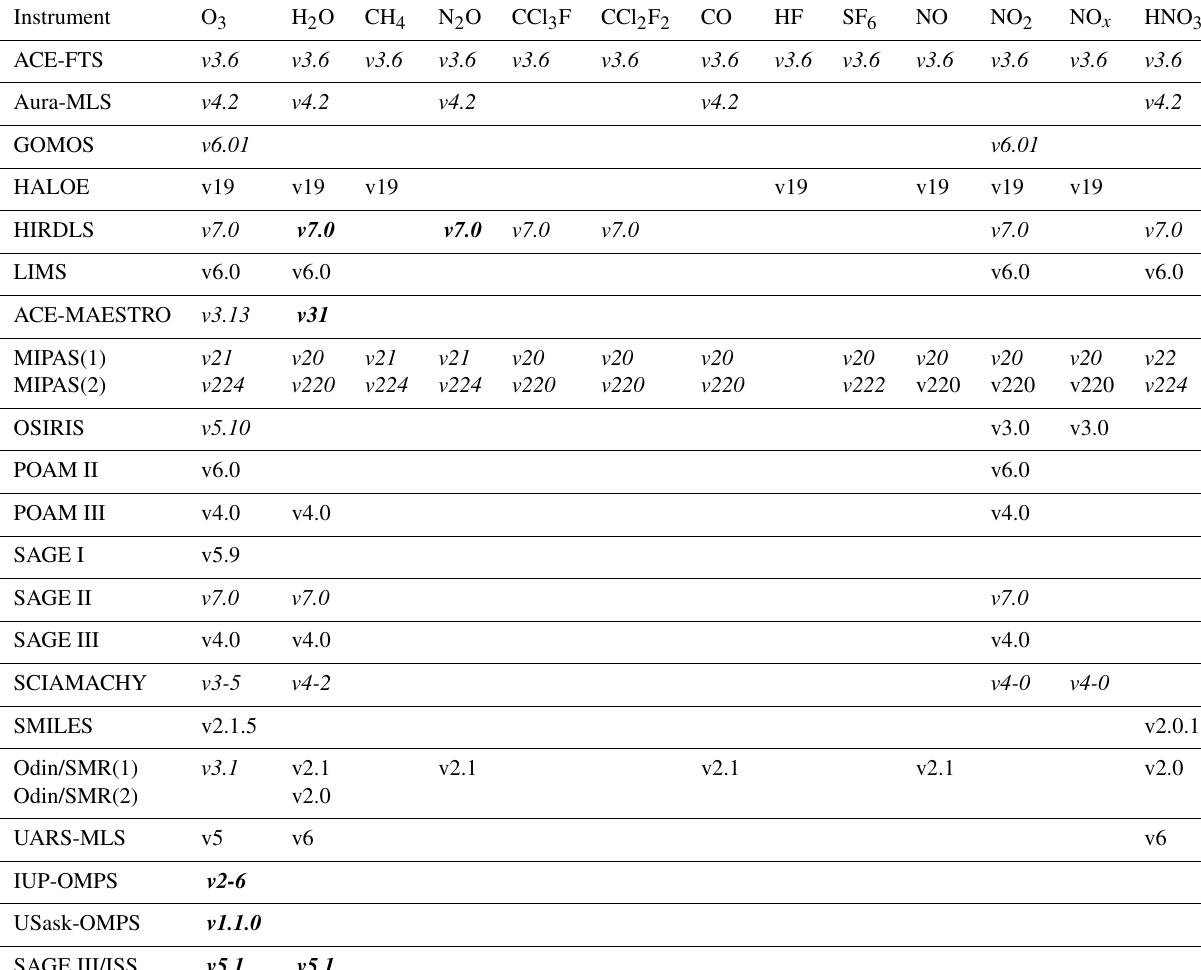
Table 1. Data versions used for the construction of the gridded zonal monthly mean datasets submitted to the SPARC Data Initiative assessment and as deposited in the Zenodo data archive (except for aerosol). Italics indicate data versions that have been updated since SPARC (2017). Bold italics indicate datasets that have been added recently, i.e., those which were not part of SPARC